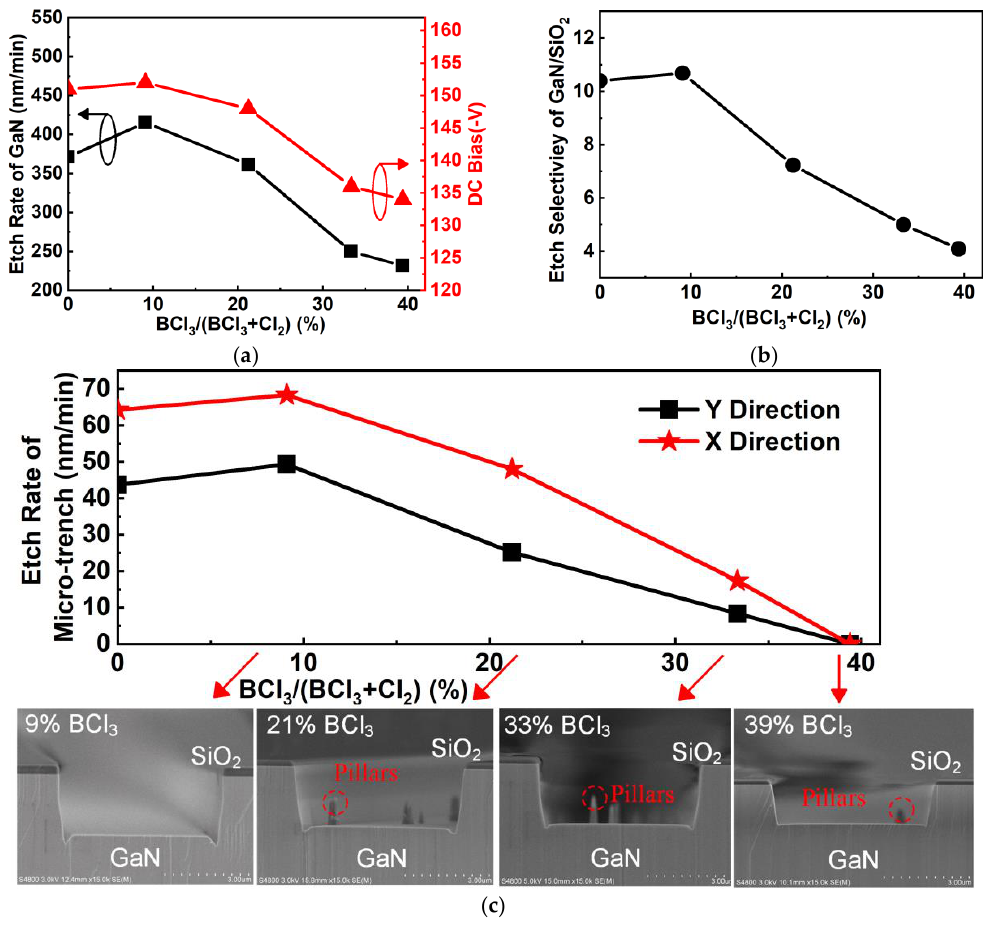
Figure 10. ( a ) Etching rate of GaN and DC bias as a function of BCl 3 content in the Cl 2 /BCl 3 gas mixture. ( b ) Etching selectivity of GaN over SiO 2 as a function of BCl 3 content in the Cl 2 /BCl 3 gas mixture. ( c ) The effect of BCl 3 content in the Cl 2 /BCl 3 gas mixture on etching rates of the microtrench in the X and Y directions. The insets of (c) show cross SEM images for samples etched with different BCl 3 concentrations.